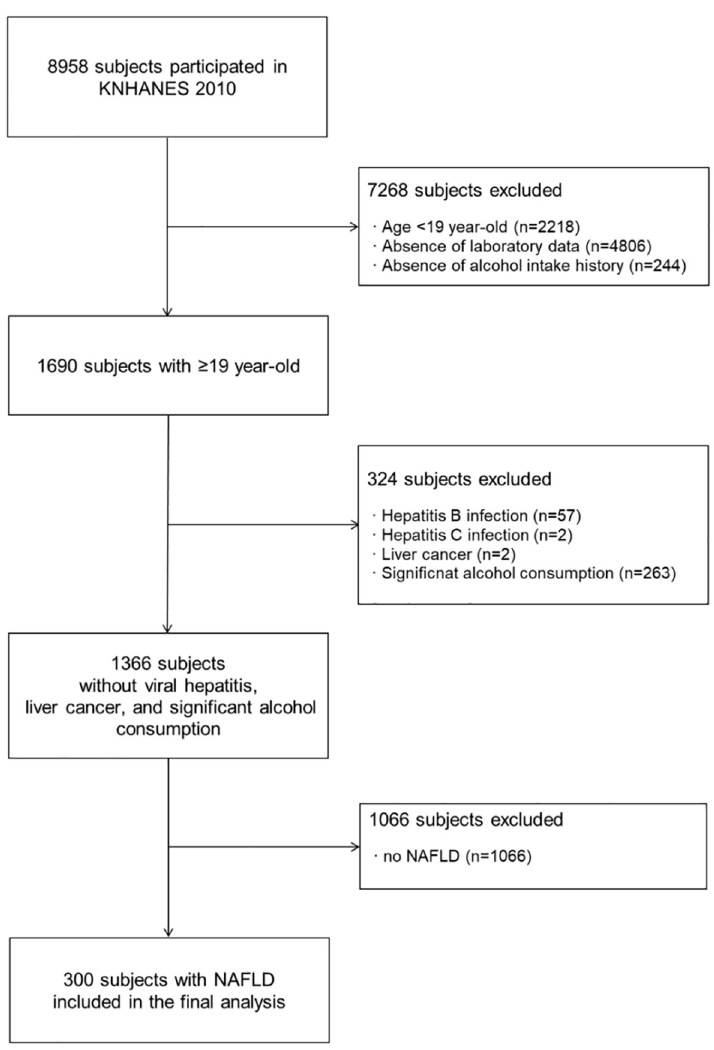
Fig 1. Flow diagram of enrolled patients. Abbreviations: KNHANES, Korea National Health and Nutrition Survey; NAFLD, non-alcoholic fatty liver disease.